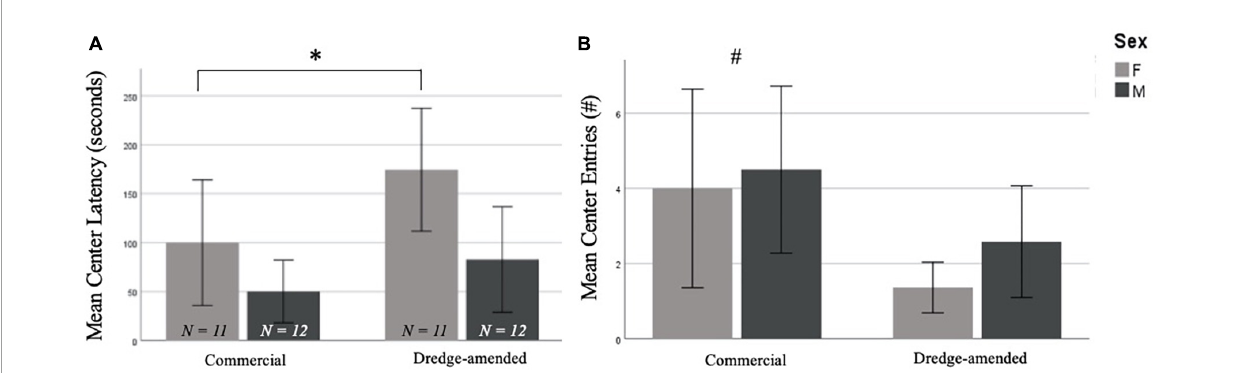
FIGURE1 Early exposure to dredge-amended corn affects adult Open Field Test (Total N = 46; N = 12 males and 11 females per corn group). Mean center latency in seconds (A) and mean number of center entries (B) in the Open Field Test with standard error bars. Females in both commercial and dredge-amended groups exhibited increased center latencies compared to males in either group (sex-specific difference indicated by ∗ ). A non-significant trend showed increased latencies in the dredge-amended group. A corn treatment difference (indicated by #) was observed for the number of center entries. Dredge-amended groups had significantly fewer center entries compared to the commercial feed corn group.